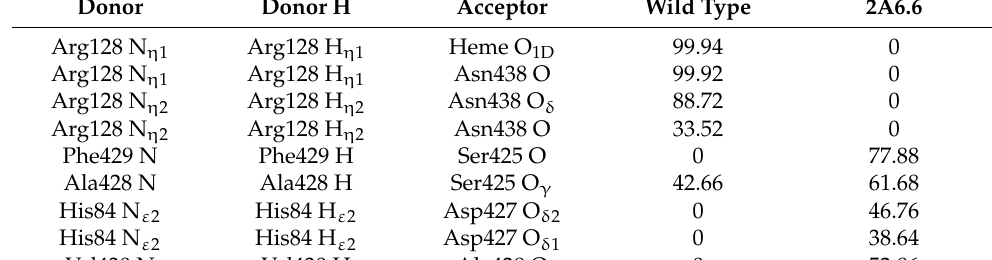
Table 4. Hydrogen bond formation involved in the structural change in CYP2A6.6.